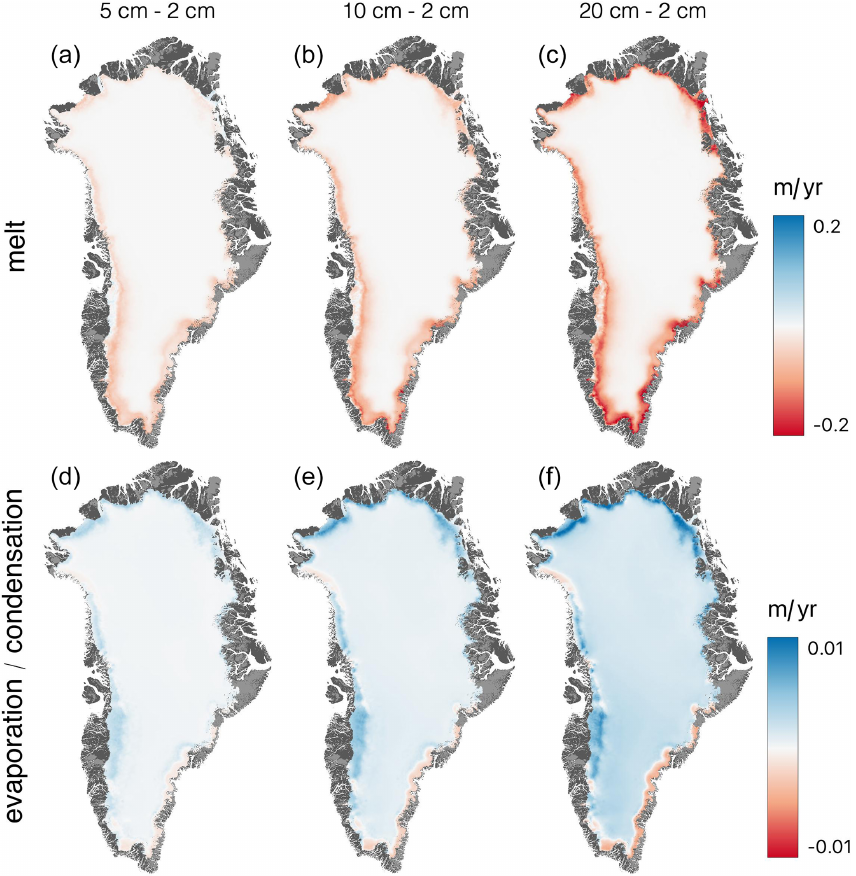
Figure 11. GEMB change in the modeled rate of melt (a–c) as well as evaporation and condensation (d–f) for near-surface model layer depths (d z top ) of 5, 10, and 20cm relative to a near-surface model layer depth of 2cm.